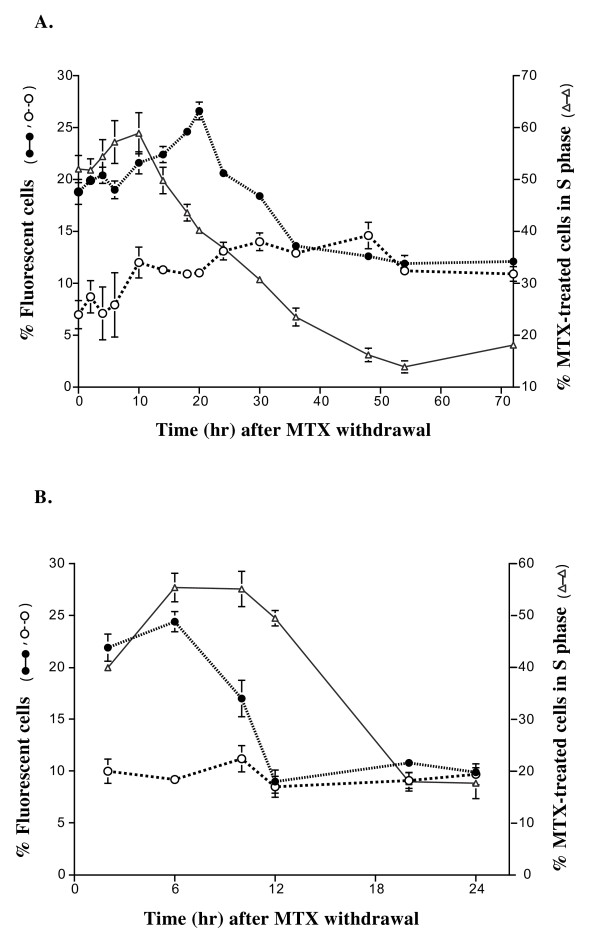
Infection efficiency of the β-gal retroviral vector. DHDK12 cells (A) and HT29 cells (B) were treated for 24 hr with (filled circle) or whithout (open circle) MTX. Cells were transduced with TG 5391 at the indicated times after MTX removal. The level of β-galactosidase activity was obtained 48 hr after the transduction by flow cytometry analysis using FDG, a fluorescent substrate of β-galactosidase. The percentage of cells in S phase (open triangle) at various time after MTX removal was determined by flow cytometry analysis of DNA content. Data are expressed as the mean ± SE from at least three separate experiments.